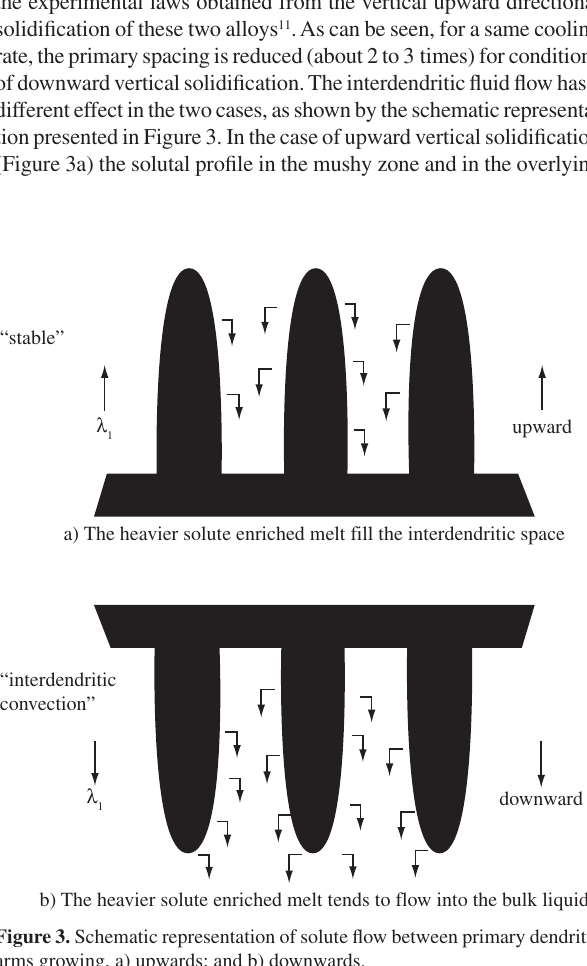
Downward Solidification: Experimental Sn-5wt.%Pb